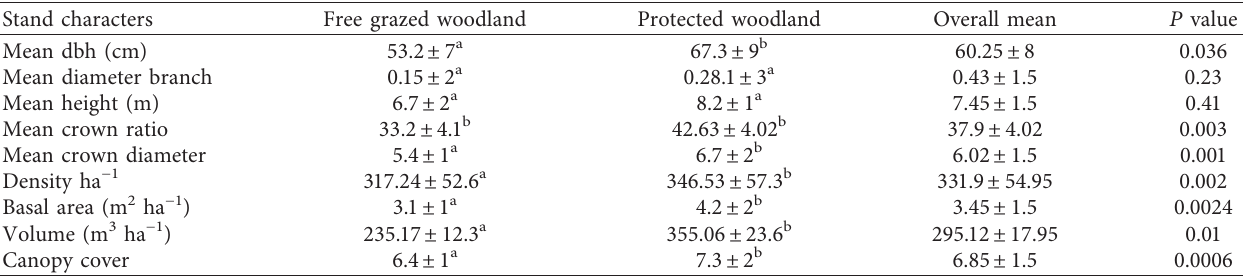
Table 3: Stand structure of protected and free grazed woodland (mean ±